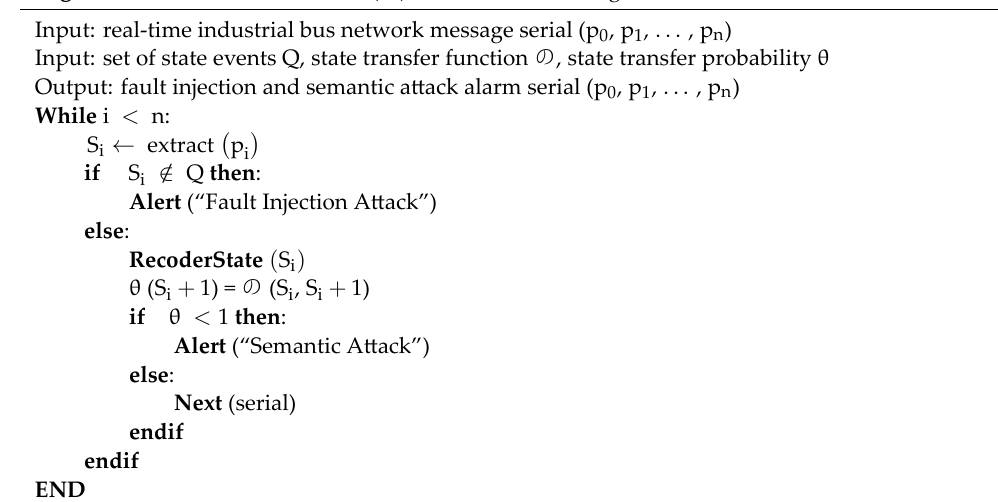
Table 2. Details of ET200 slave configuration parameters.